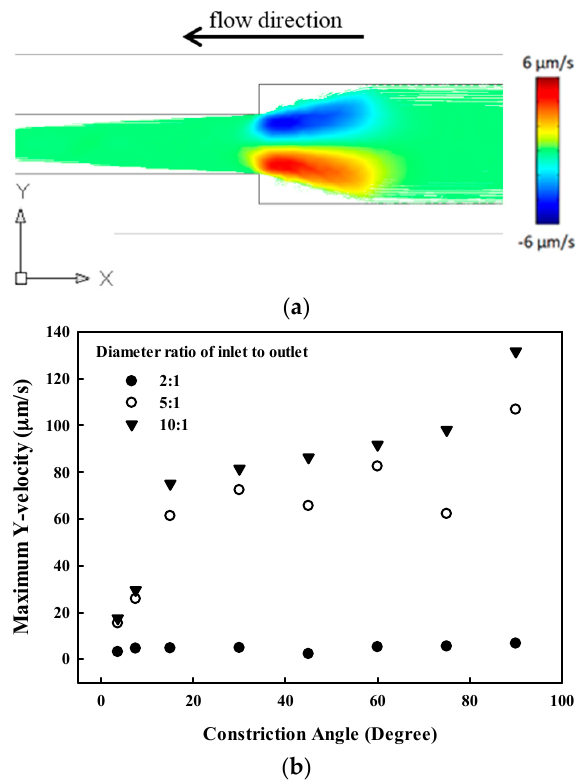
Figure 3. ( a ) Y-velocity of particle under laminar flow in the microchannel at the constriction angle of 90°, inlet of 100 μ m, and outlet of 50 μ m; and ( b ) maximum velocity under different constriction angles from 3.6° to 90.0° and diameter ratios of the inlet to the outlet at the inlet of 100 μ m.